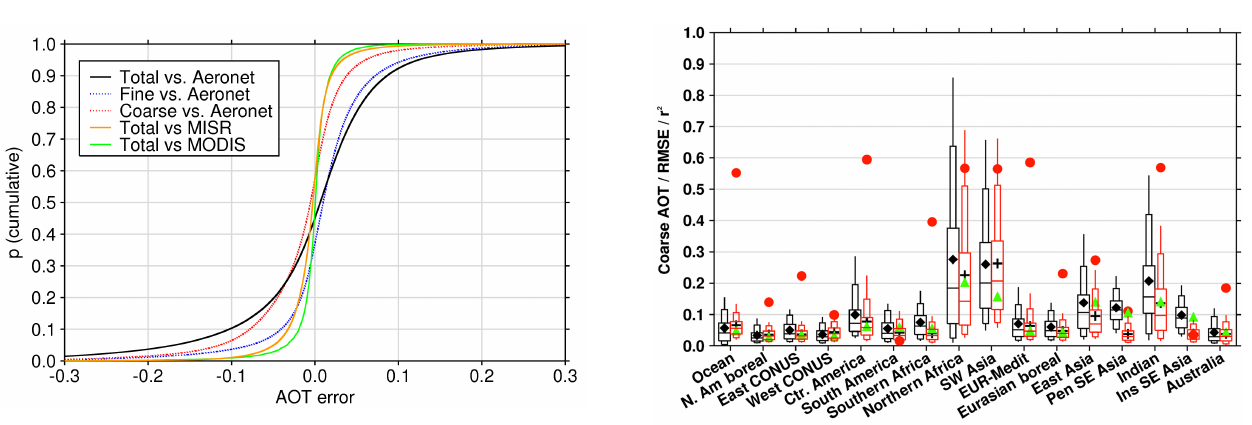
Figure 11. Same as Fig. 10, except for coarse-mode AOT at 550nm.